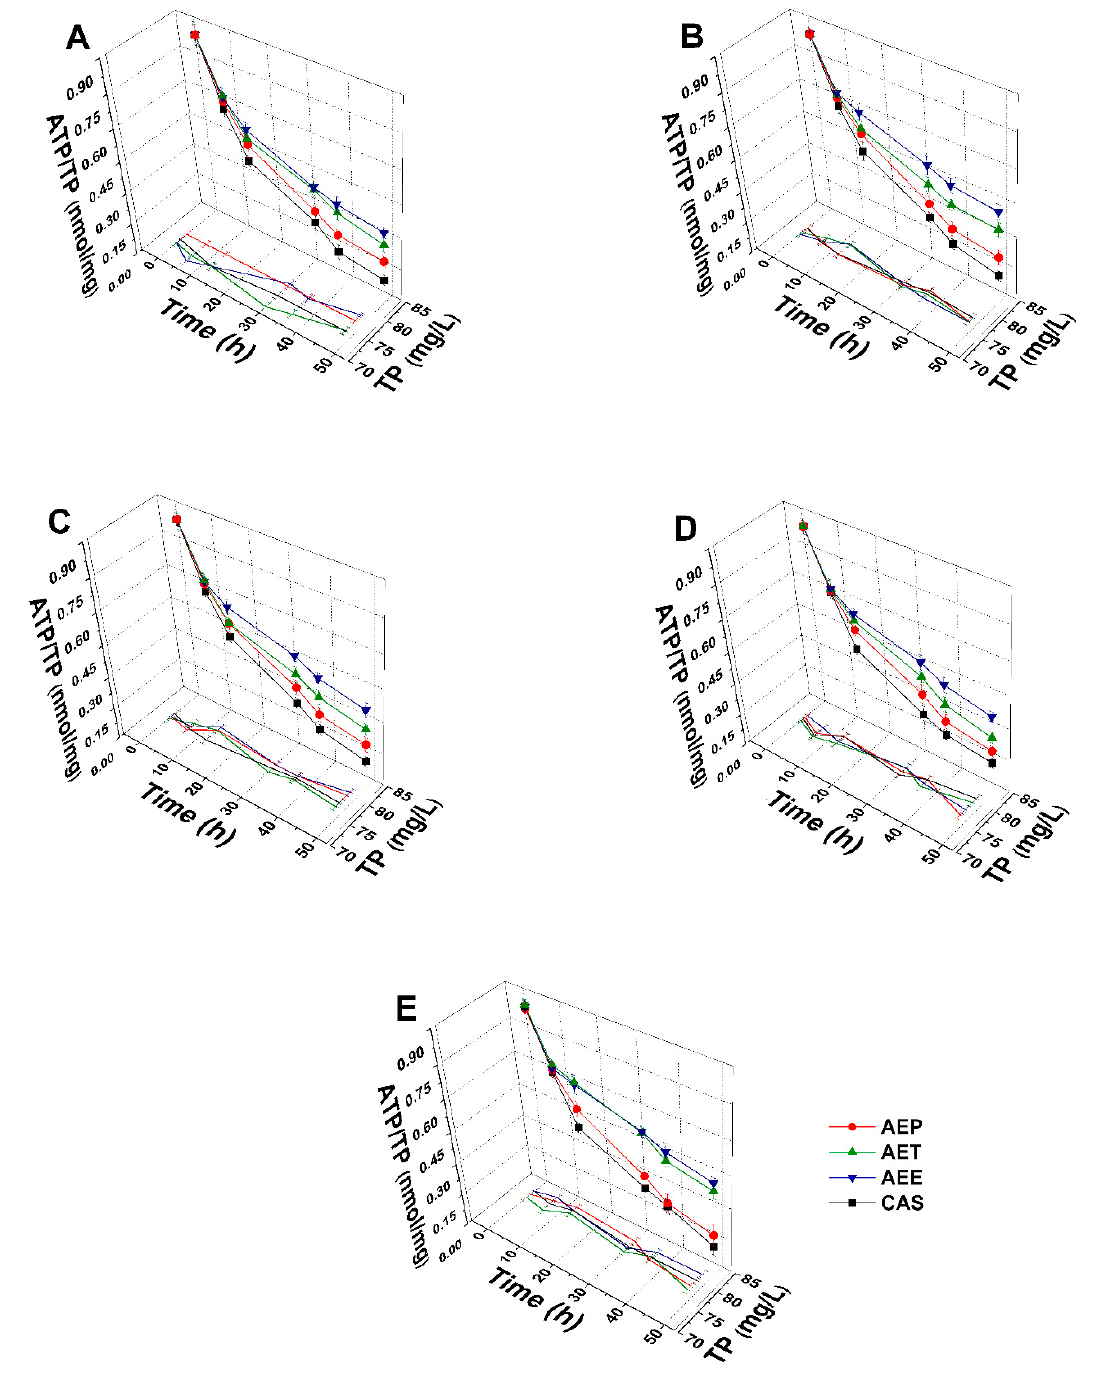
Figure 12. Effects of AEP, AET, and AEE at their MEC 10 concentrations on the total protein content (TP) and intracellular ATP/TP ratio of the planktonic S. pombe ( A ), C. albicans ( B ), C. tropicalis ( C ), C. dubliniensis ( D ) and C. krusei ( E ) compared to their respective 0 h samples and caspofungin (CAS) standard antimicrobial controls after 6, 12, 30, 36 and 48 h of treatment (mean ± SD, n = 6 independent experiments each with three technical replicates).